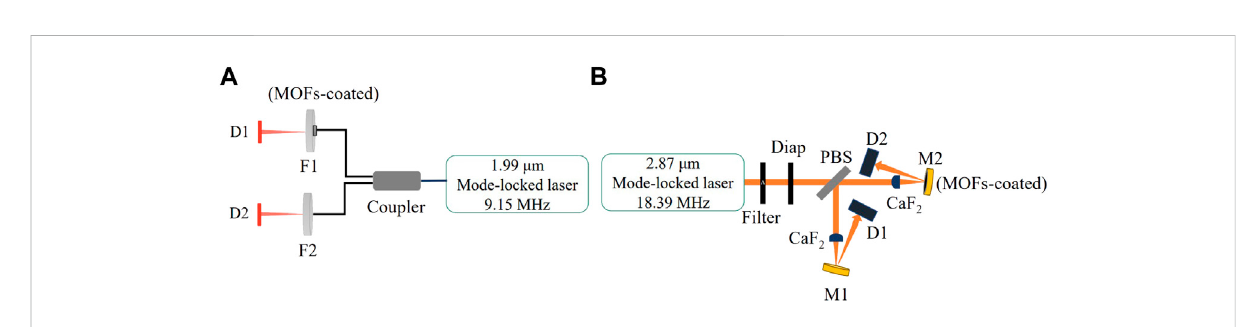
FIGURE 3 Nonlinear absorption experimental setup, (A) at 1.99 μ m, (B) at 2.87 μ